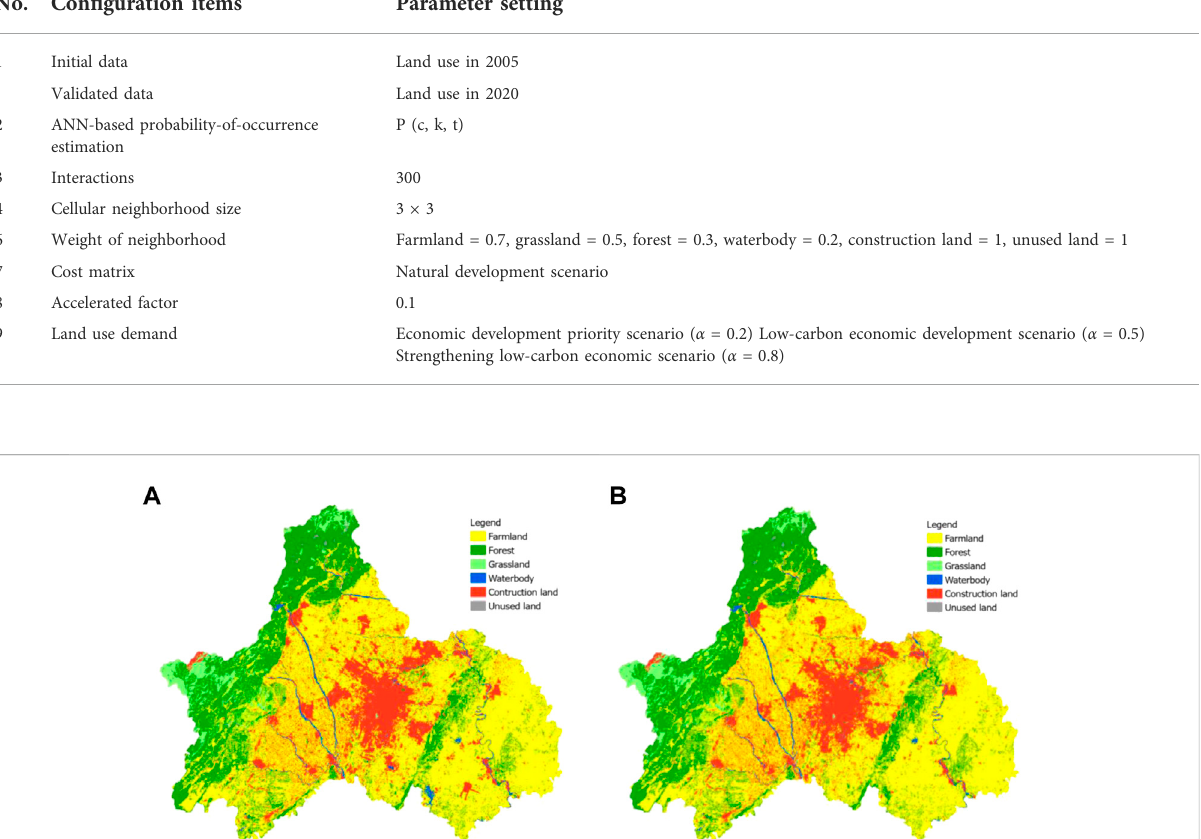
TABLE 5 Parameter settings in the CA module.